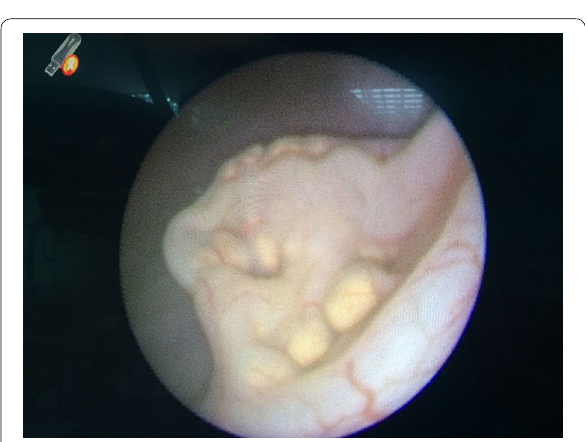
Fig. 2 Left ureterocele containing multiple stones during cystoscopy procedure